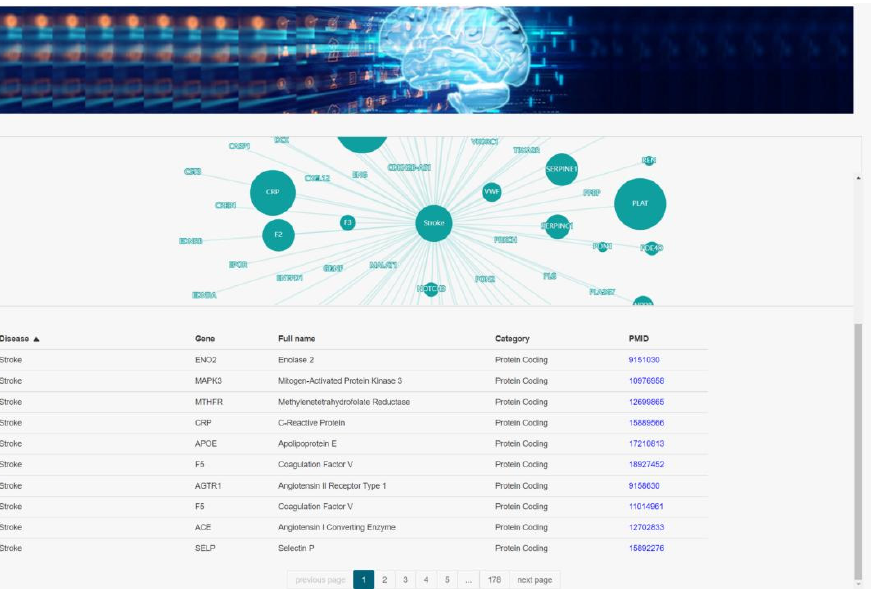
Figure 3. Page reporting detailed results of the retrieved genes related to a disease. The top visuali- zation shows the link between disease and gene, with larger dots representing genes indicating more literature supporting the link. The lower part shows the specific annotation information.